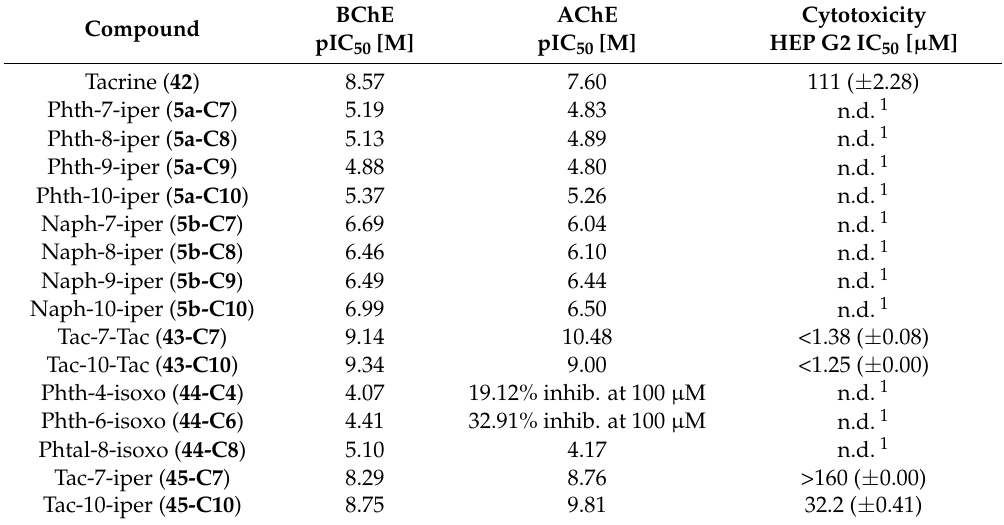
Table 1. Cholinesterase activity and cytotoxicity of the M2 bitopic compounds and tacrine hybrids. BChE from equine serum, AChE from electric eel. [110].